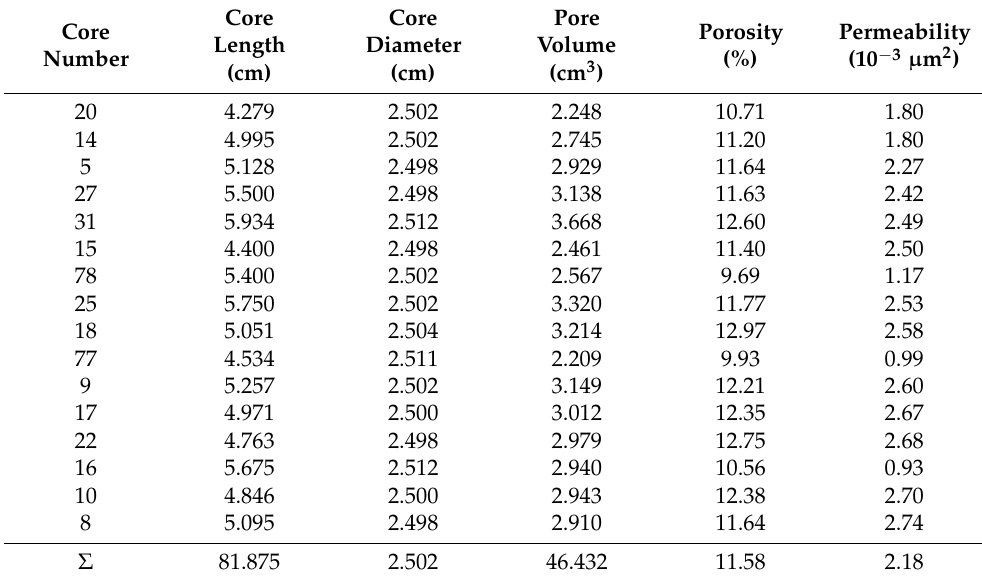
Table 2. Sequence of low permeability long core.